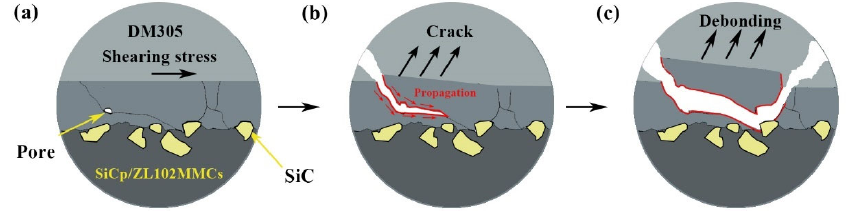
Figure 10. Fracture process evolution diagram of joint: ( a ) the initiation of microcracks, ( b ) crack propagation, ( c ) fracture of the joint.